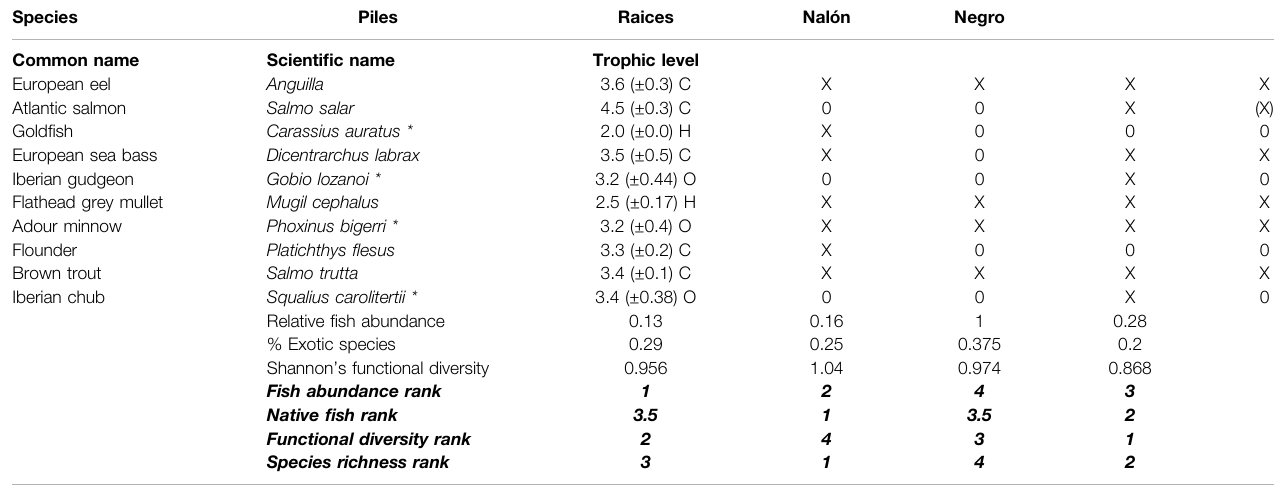
TABLE 4 | River features. Fish species inventoried in the four rivers and their trophic level, relative fi sh abundance, fi sh diversity as number of species, and % of exotic fi sh species. Rank scores of river features are given in bold italics.